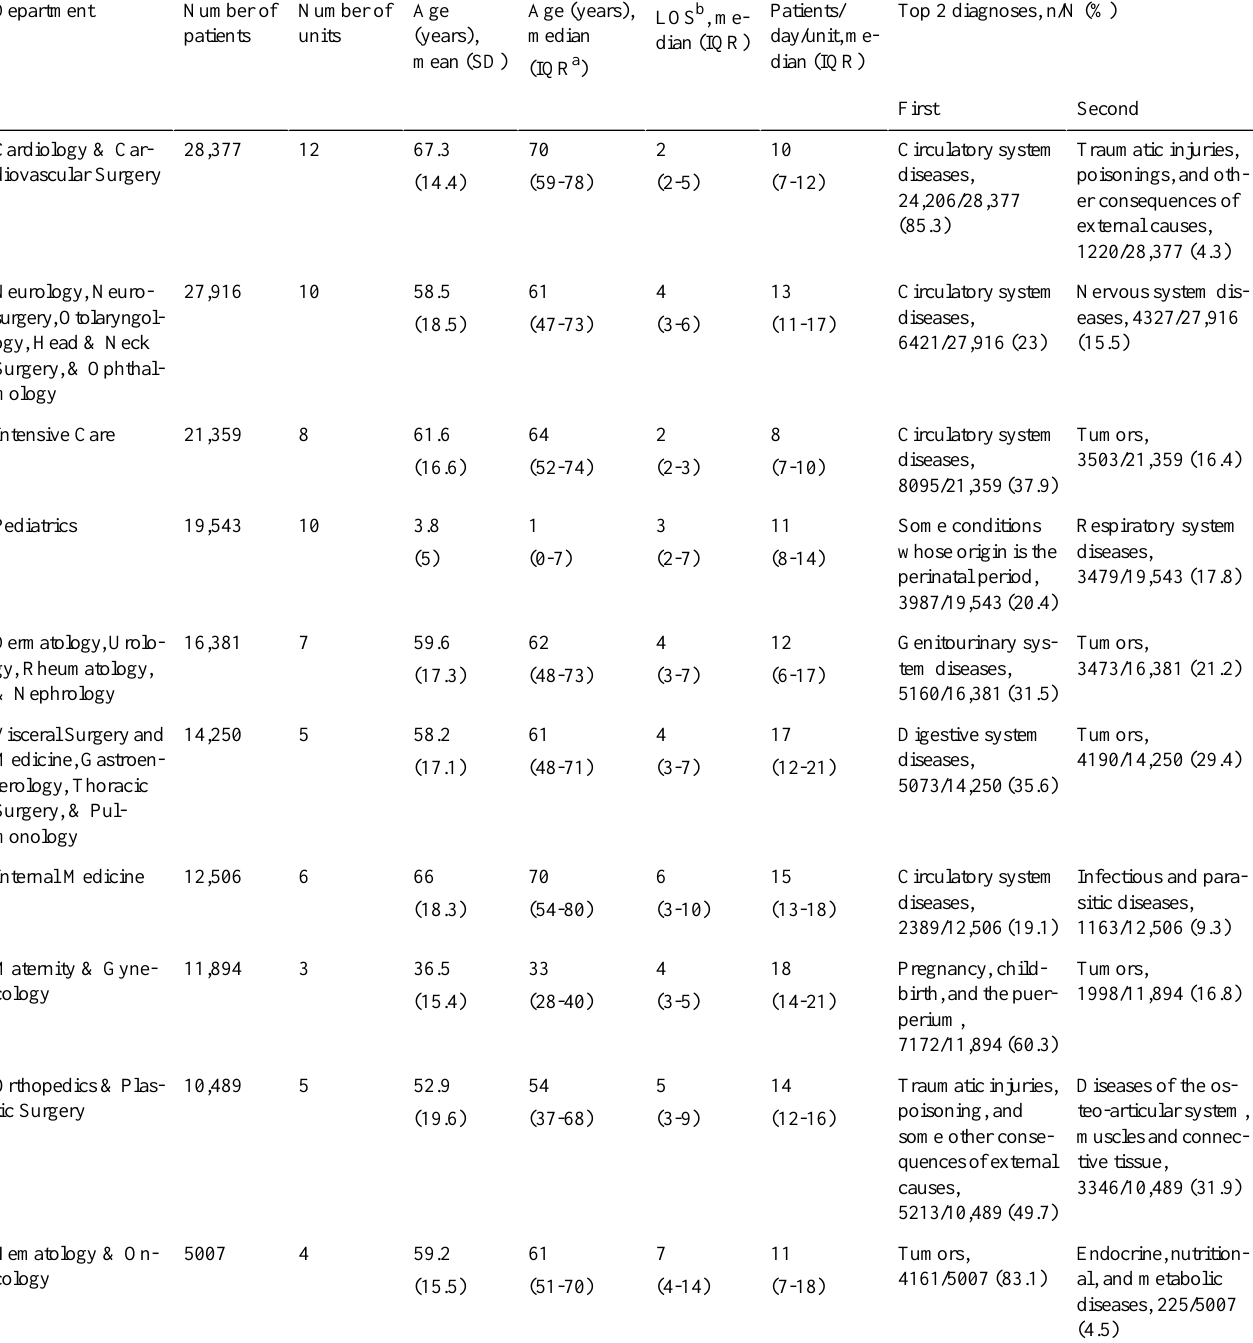
Table 2. Descriptive overview of each department classified by the overall number of patients for